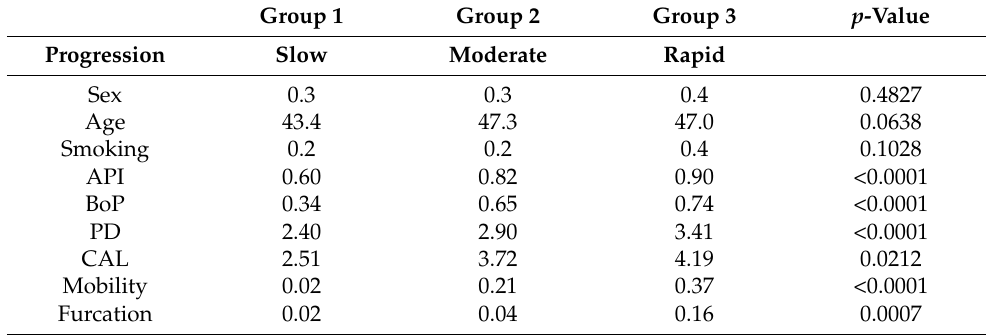
Table 3. Periodontitis grade: probability of